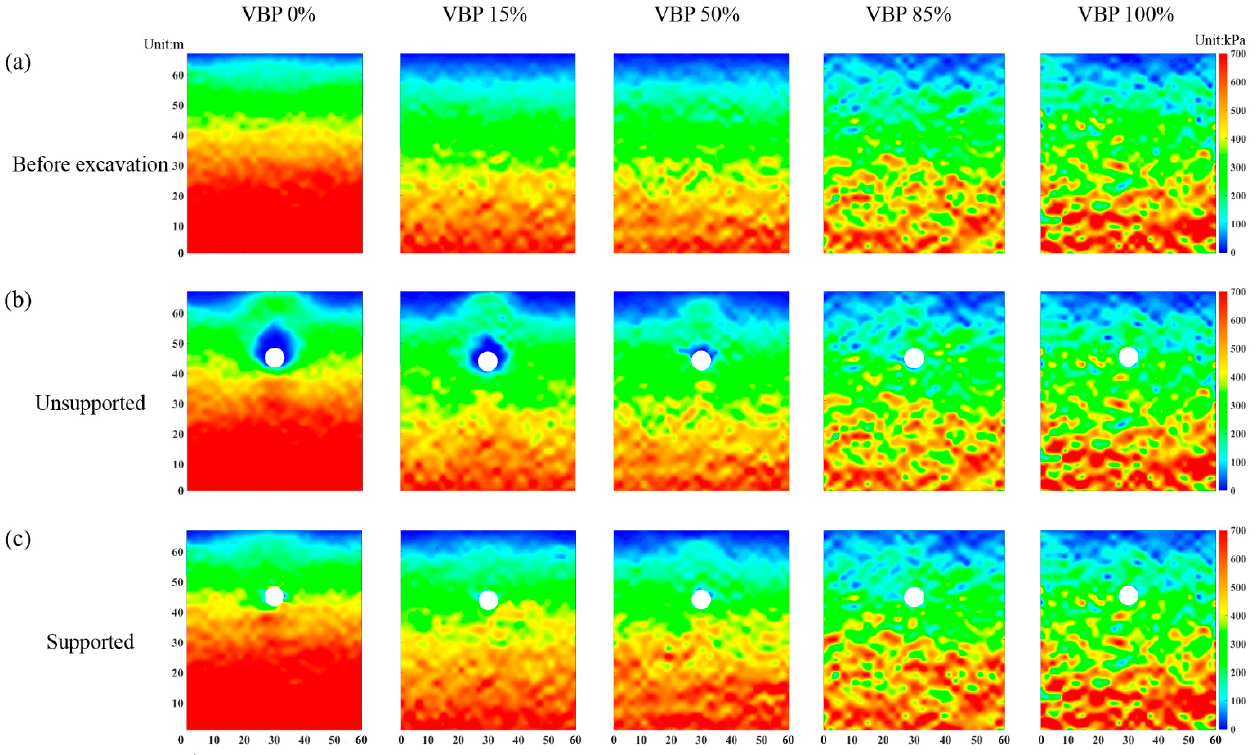
Figure 12. The distribution of horizontal stresses in the computational domain: ( a ) initial state before excavation, ( b ) unsupported tunnel excavation, and ( c ) supported tunnel excavation by rigid lining.